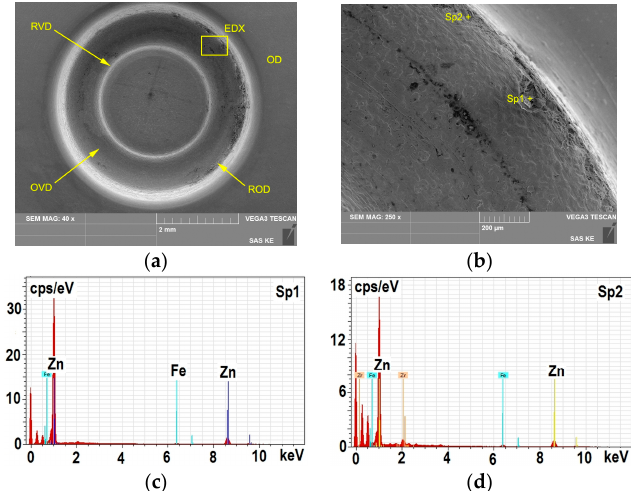
Figure 14. ZrN die-defect in the radius surrounding the cavity of the shaped surface ROD: ( a ) wear disposition of the shaped part of the die; ( b ) detail of ROD; ( c ) EDX microanalysis of Sp1 area; ( d ) EDX microanalysis of Sp2 area.